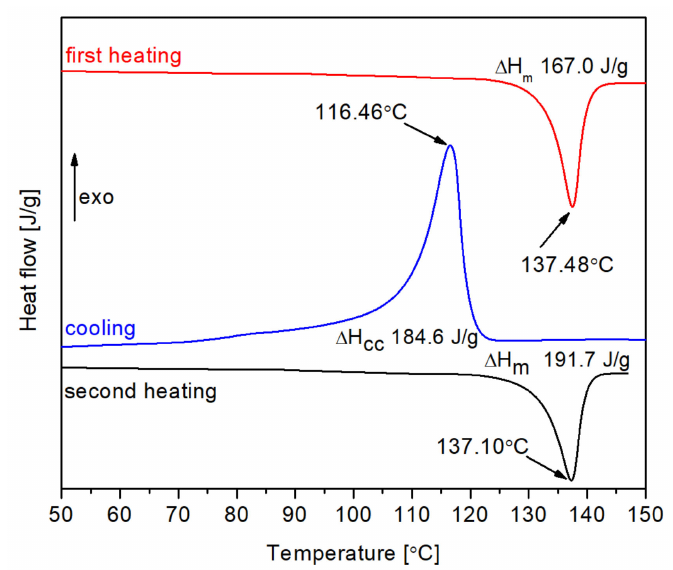
Figure 3. DSC thermograms of nonirradiated HDPE. The sample was cycled through heating, cooling, and heating at a temperature gradient of 10 deg/min under nitrogen